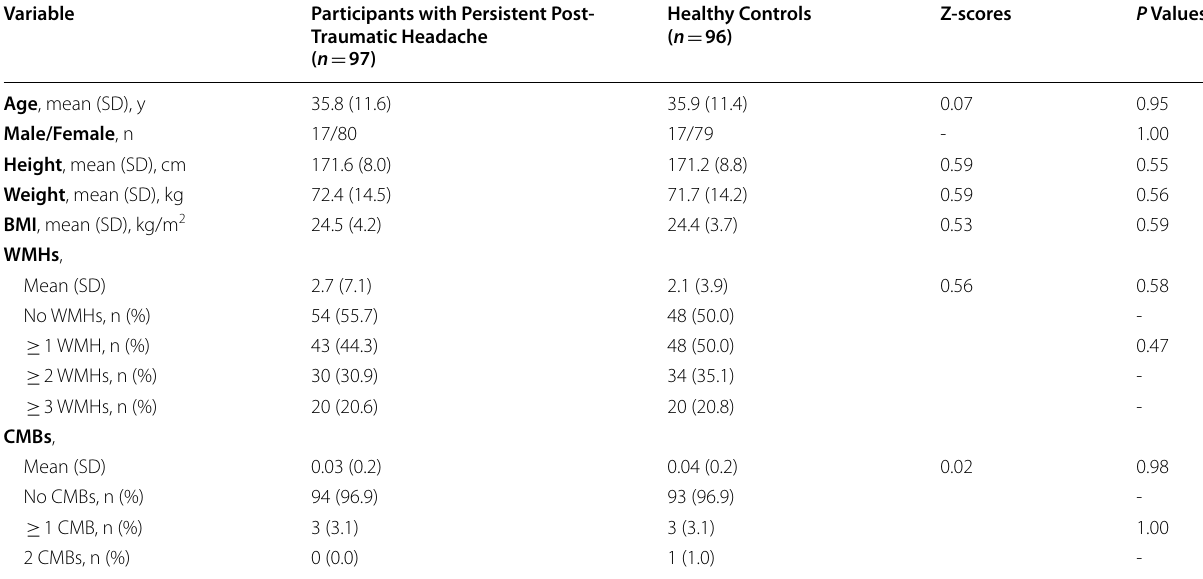
Table 1 Summary of the Study Populations